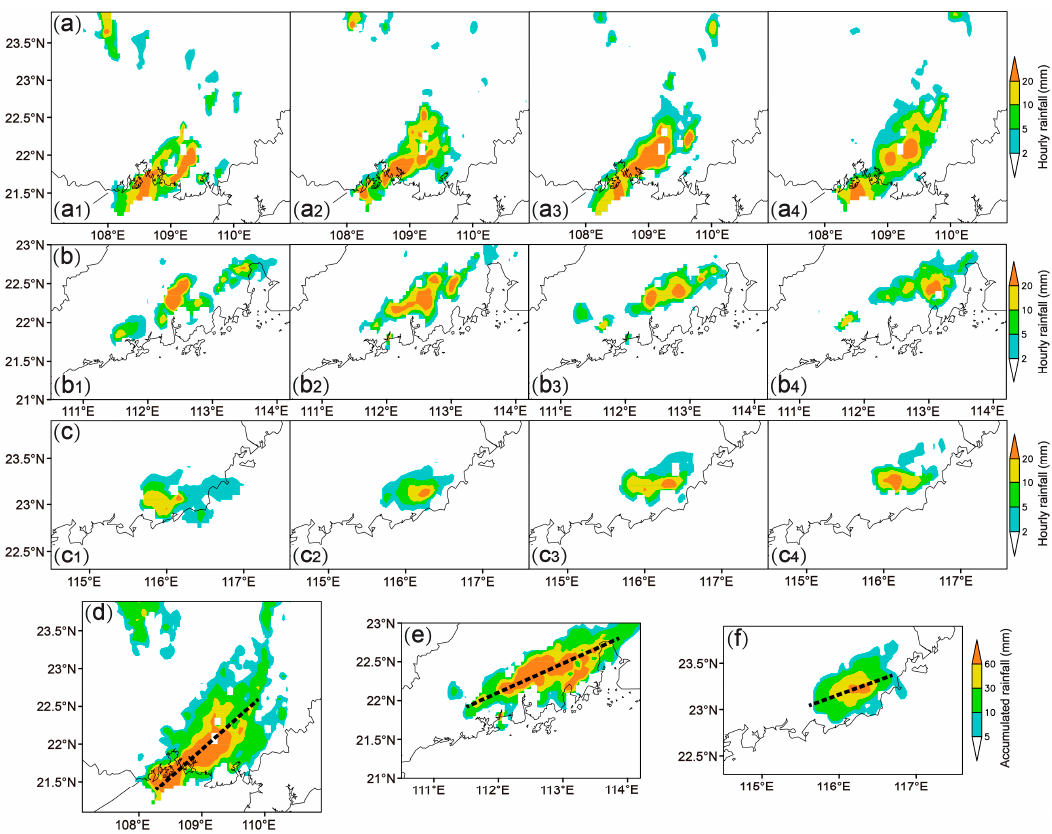
Figure 2. ( a – c ) Hourly rainfall distribution (units: mm) evolution and ( d – f ) cumulative rainfalls (units: mm) for the coastal organized warm-sector rainfall (OWSR) events occurring in the coastal areas of ( a , d ) Guangxi Province, ( b , e ) west Guangdong Province, and ( c , f ) east Guangdong Province, respectively. The dashed lines in ( d – f ) indicate the axes of the cumulative rainfall distributions. The times for panels a 1 –a 4 , b 1 –b 4 , and c 1 –c 4 indicate 2100 UTC 24–0000 UTC 25 June 2014, 0800–1100 UTC 23 April 2012, and 0900 – 1200 UTC 9 April 2012, respectively.